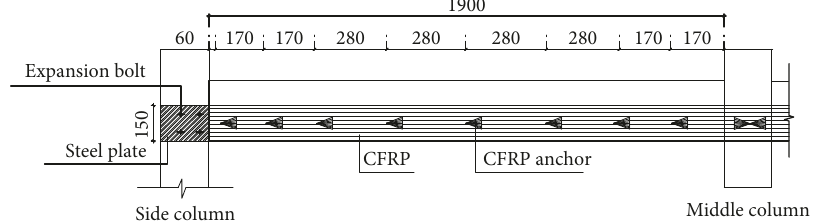
Figure 2: HFRP anchors arrangement.